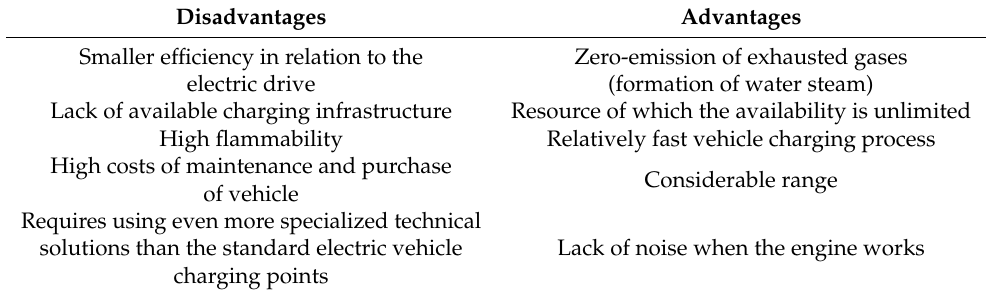
Table 1. Disadvantages and advantages of using the hydrogen drive. Disadvantages Advantages Smaller efficiency in relation to the Zero-emission of exhausted gases electric drive (formation of water steam) Lack of available charging infrastructure Resource of which the availability is unlimited High flammability Relatively fast vehicle charging